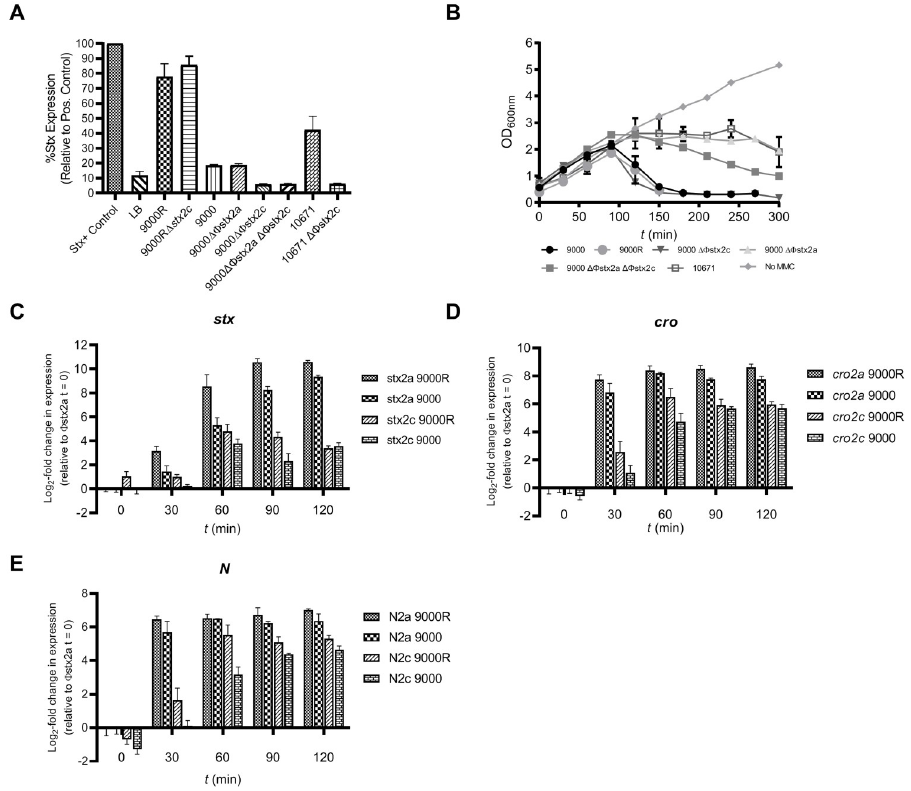
Fig 2. Stx2 toxin production, lysis and F stx2 gene expression. (A) Pan Stx2 toxin production from PT21/28 strains 9000, 9000R, PT32 strain 10671 and genetic derivatives was measured by ELISA 24 h post induction with MMC. Values are expressed relative to an inactivated Stx toxin control used in each assay. The mean ± SEM from four biological replicates (n = 4) are shown for each strain. Samples were first diluted either 10 − 4 or 10 − 3 to be within the assay limits of detection. LB = Lysogeny Broth without bacteria. (B) Lysis of strains 9000, 9000R, 10671 and genetic derivatives was measured spectrophotometrically as a drop in culture OD 600nm . Mean OD 600nm values ± SEM from four biological replicates (n = 4) are shown. No MMC = growth of strain 9000 without MMC. Expression of the late gene stx2B (C) and early gene regulators cro (D) and N (E) was monitored from both F stx2a and F stx2c in strains 9000 and 9000R after induction with MMC. The mean ± SEM from four biological replicates (n = 4) is shown. Data for stx2 , N and cro genes is expressed relative to the F stx2a encoded analogues ( stx2a , N2a , cro2a ) at time ( t) = 0,